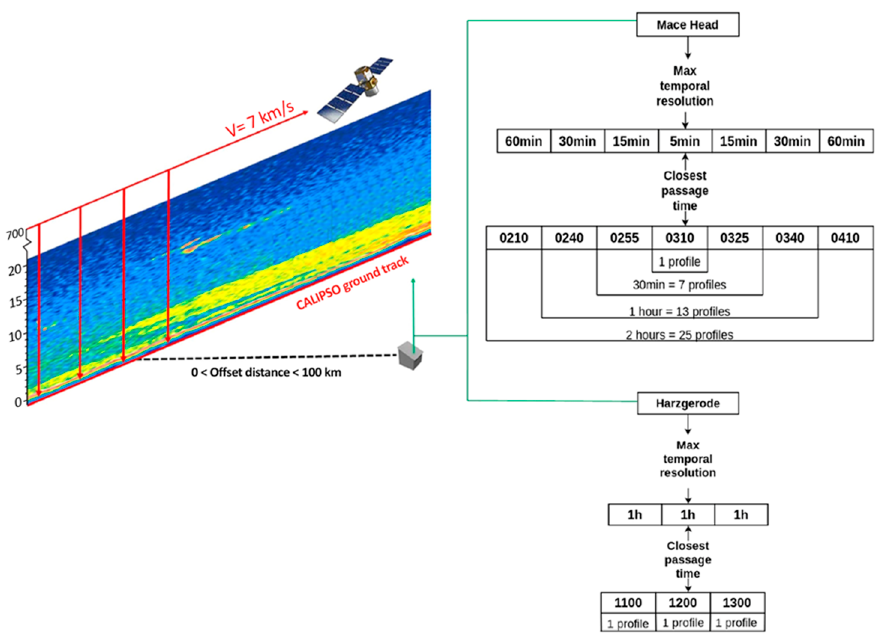
Figure 2. Comparison methodology between CALIPSO, Mace Head and Harzgerode. The examples given for the ground–based stations are real cases which are further discussed in the next sections. The vertical red arrows represent CALIOP’s vertical profiles that are spatially separated by 5 km. (Adapted from [55], copyright permission from Gary Gimmestad). The interval between the white lines in Figure 1 (bottom) shows an example of the along–track averages within 100 km from CALIOP that are used for the comparison. At the same time, the interval between the black lines in Figure 1 (top) represents the one–hour interval from the ground–based data used for the comparison with CALIOP. Finally, the di ff erence in the vertical resolution of the instruments is considered. The altitude scale of the ground–based ceilometer profiles is adjusted to be the same as of CALIOP (above mean sea level, m.s.l.) by vertically averaging the data every 60 m. Besides, the evaluation of CALIOP backscatter coe ffi cient at 1064 nm is carried out in the region above 0.3 km m.s.l for Mace Head and 0.6 km m.s.l for Harzgerode to account for overlap e ff ects, and ground returns. Furthermore, only altitude ranges where both instruments